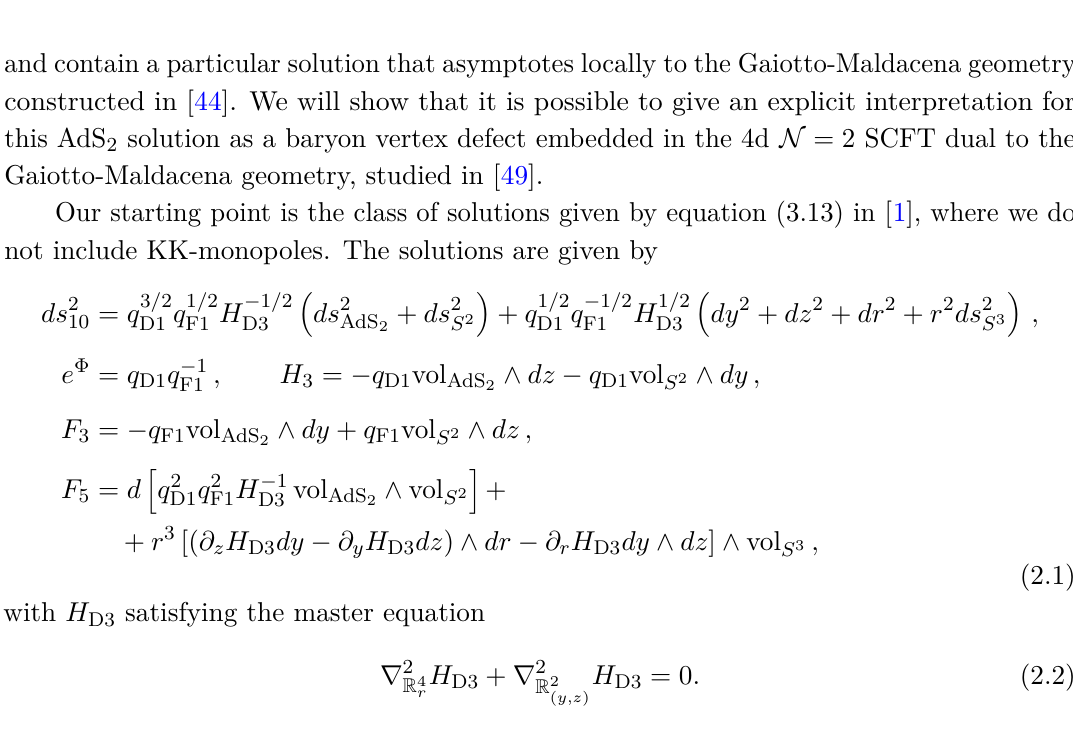
Table 1 . BPS/8 intersection describing D1-F1-D5-NS5 branes ending on D3 branes. x 1 , x 2 , x 3 are the coordinates realising the SO(3)